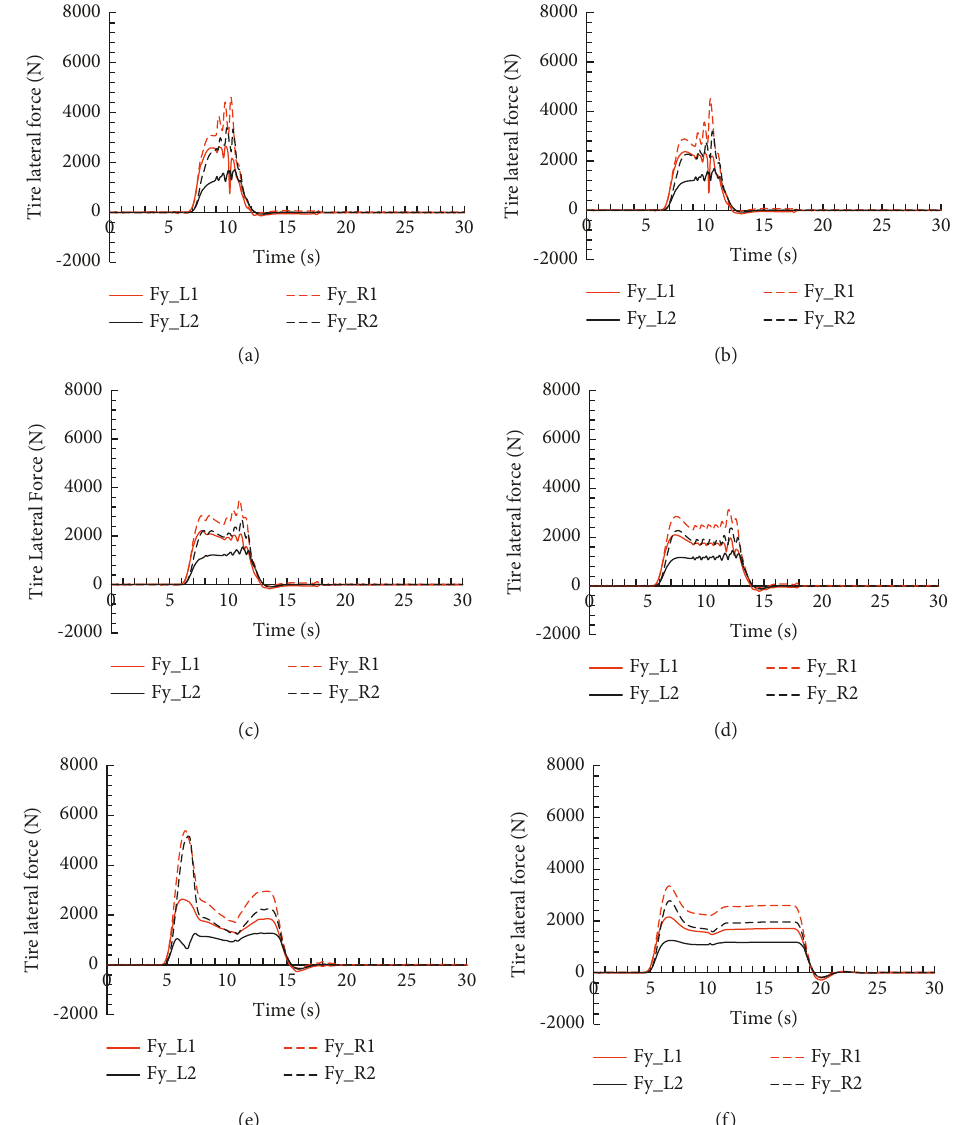
Figure 17: Tire lateral force curves on dry pavement: (a) R